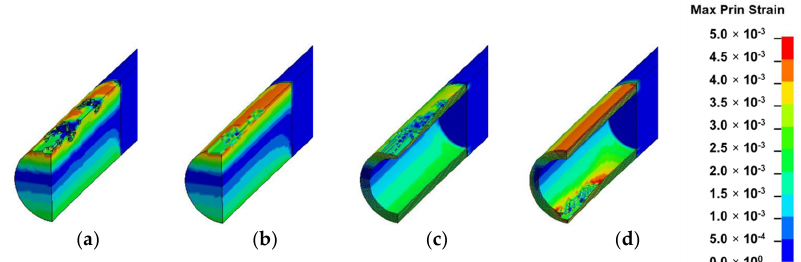
Figure 10. Fringe plots of maximum principal strain of: ( a ) solid-homogeneous; ( b ) solid-inhomogeneous; ( c ) hollow-homogeneous and ( d ) hollow-inhomogeneous models in bending mode. Materials 2020 , 13 , x FOR PEER REVIEW